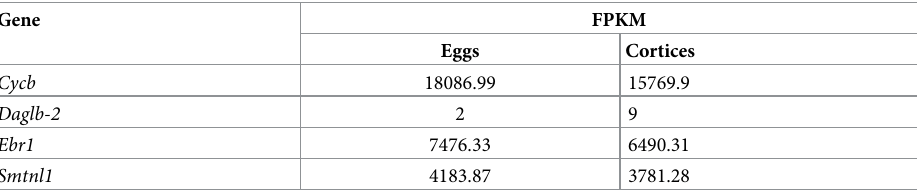
Table 1. FPKM values of new candidate reference genes and gene of interest. Gene FPKM Eggs Cortices Cycb